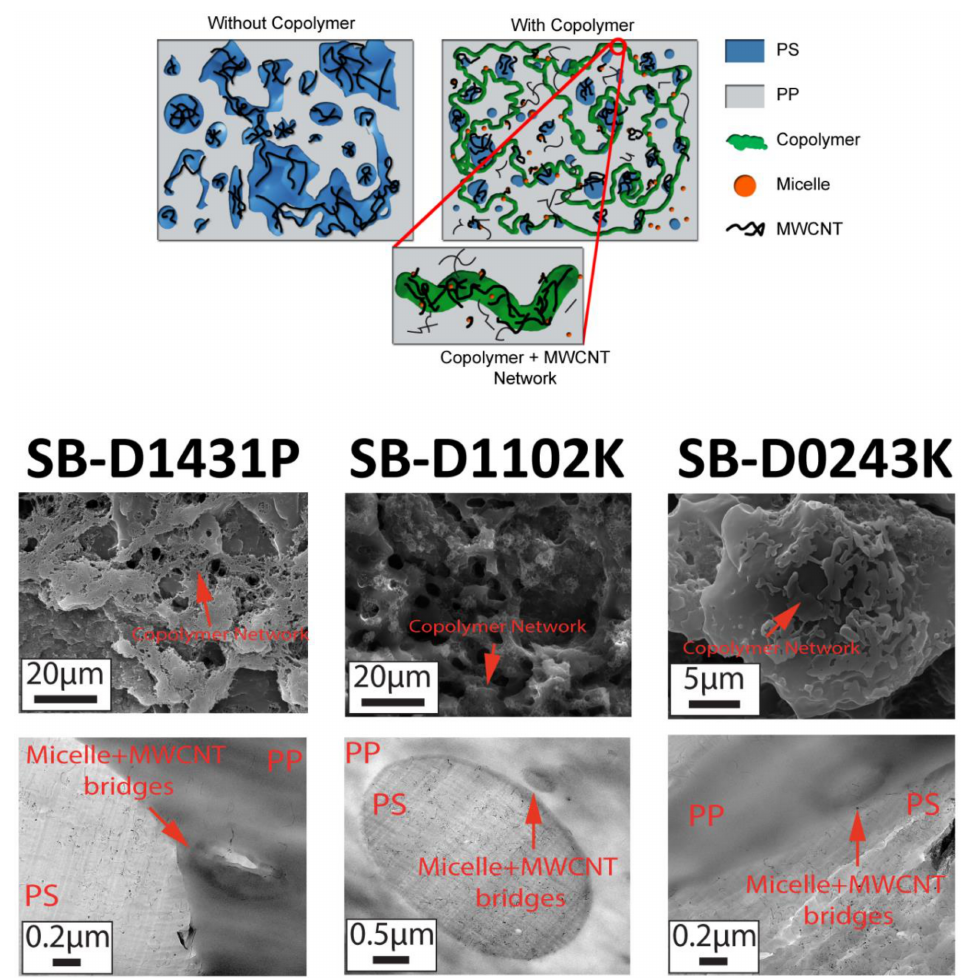
Figure 10. Schematic of the conductive network in PP:PS/70:30/MWCNT nanocomposites without and with block copolymers. SEM micrographs show the copolymer network and TEM micrographs display that MWCNTs bridge the micelles and PS